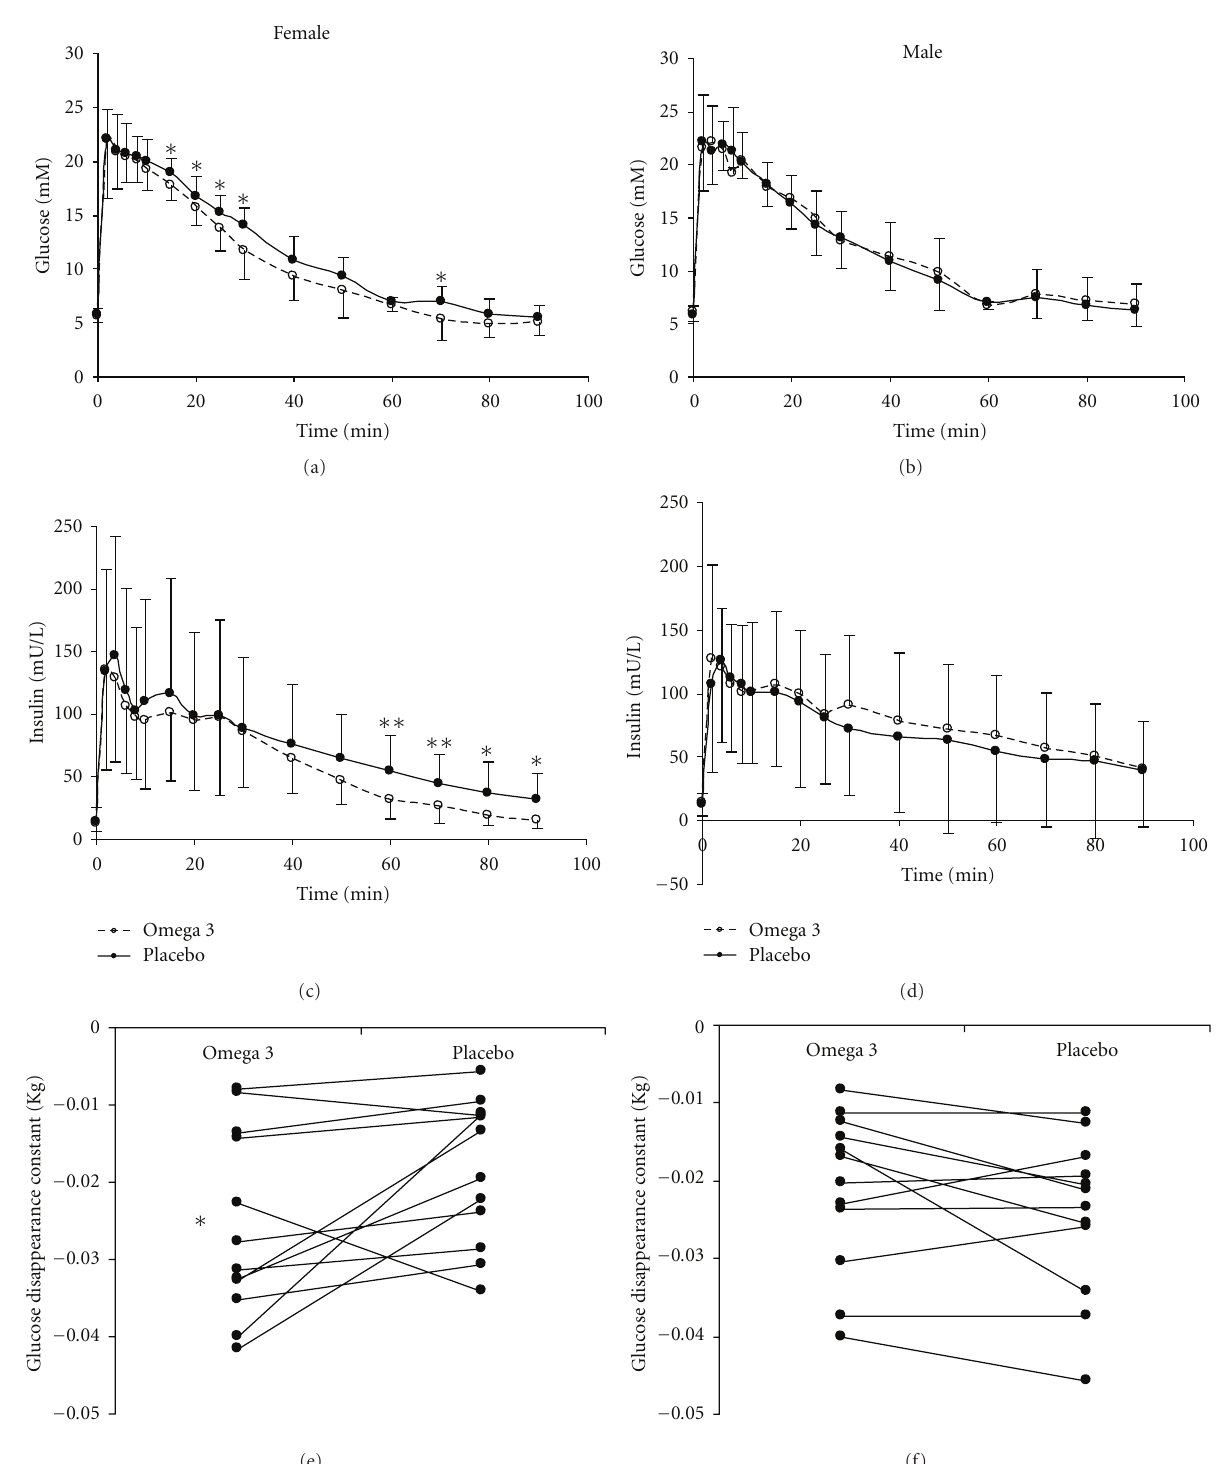
Figure 1: Intravenous glucose tolerance test: glucose (upper panels) and insulin (middle panels) response curves after omega-3 LCPUFA or placebo supplementation, in male (right panels) and female (left panels) obese adolescents. Omega-3 LCPUFA supplementation increased glucose disappearance rate (lower panels) and improved restoration of insulin concentration in female, but not male subjects. ∗ P < 0 . 05, ∗∗ P < 0 . 01 compared with